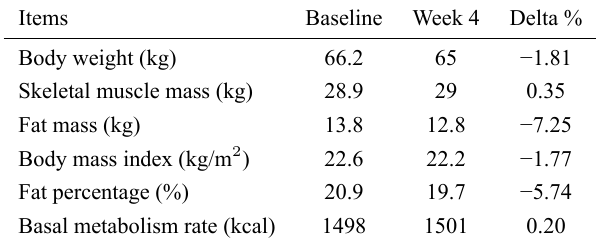
Table 3. Changes in granulocytes and immunocytes. Table 4. Changes in body composition.